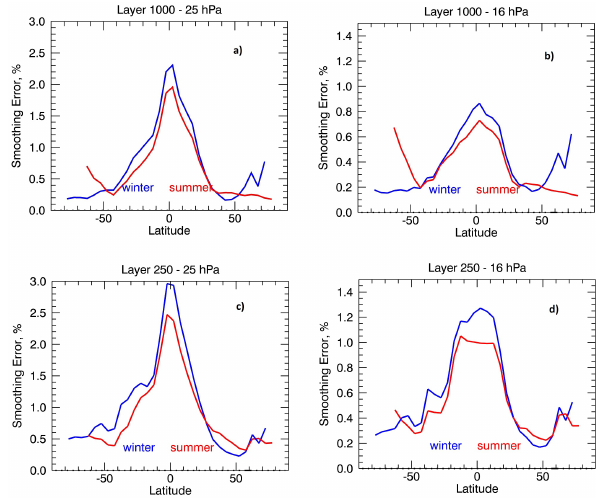
Fig. 7. Smoothing error as a function of latitude for different combi- nations of layers in the lower stratosphere/troposphere: (a) surface– 25hPa; (b) surface–16hPa; (c) 250–25hPa; and (d) 250–16hPa. Blue lines show errors in winter months (DJF) and red lines errors in summer months